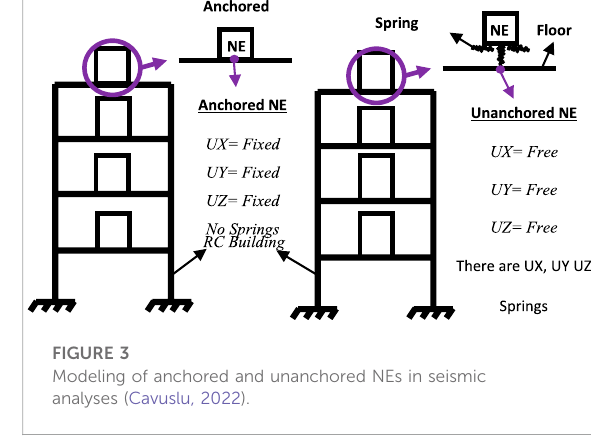
Modeling of anchored and unanchored NEs in seismic analyses (Cavuslu, 2022).